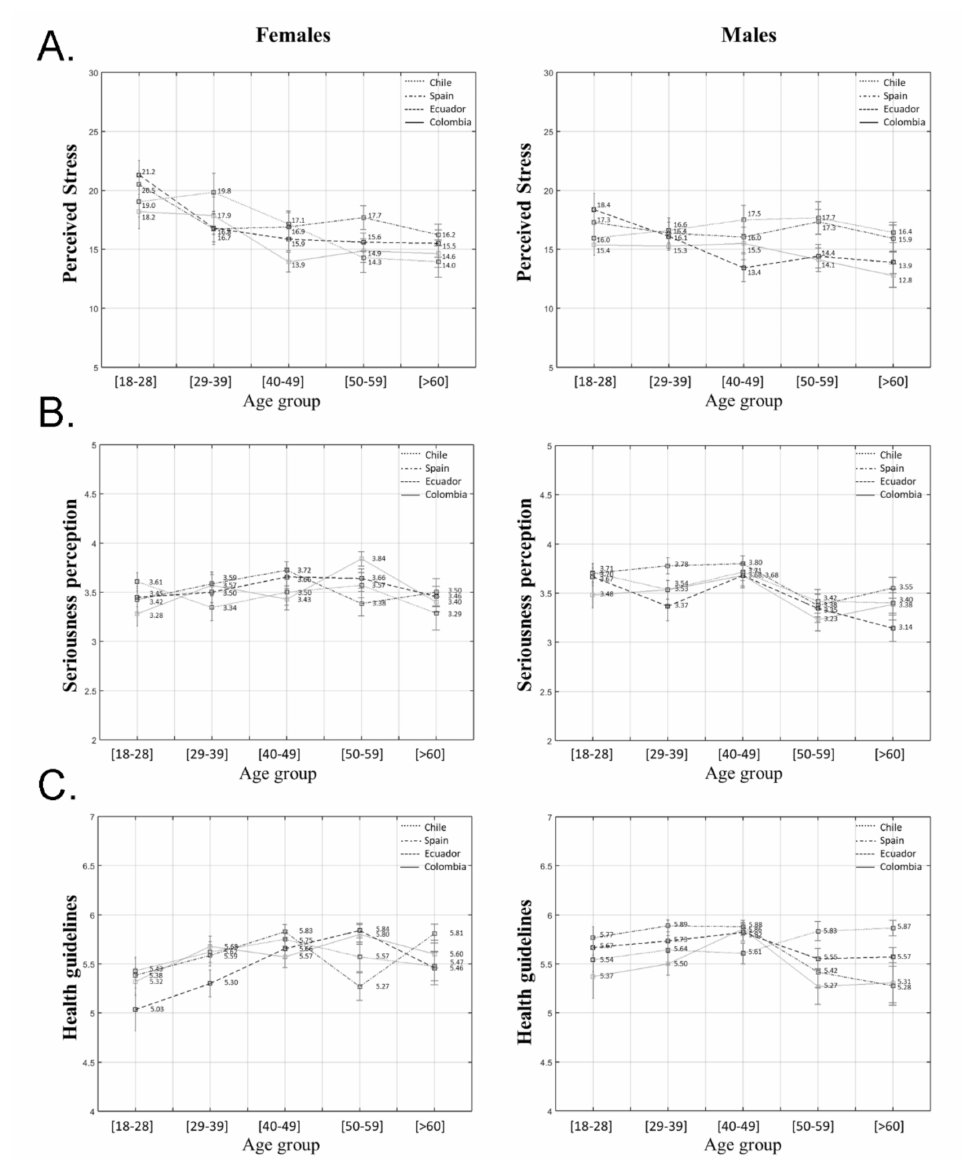
Figure 1. Values for ( A ) perceived stress, ( B ) seriousness perception, and ( C ) health guidelines adherence differentiated by gender, age group, and